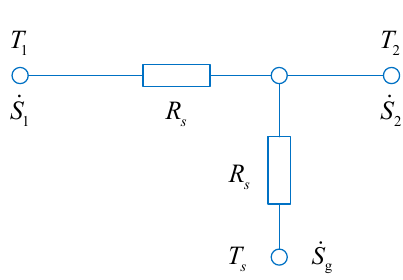
Figure 2. Equivalent model of entropy conduction.